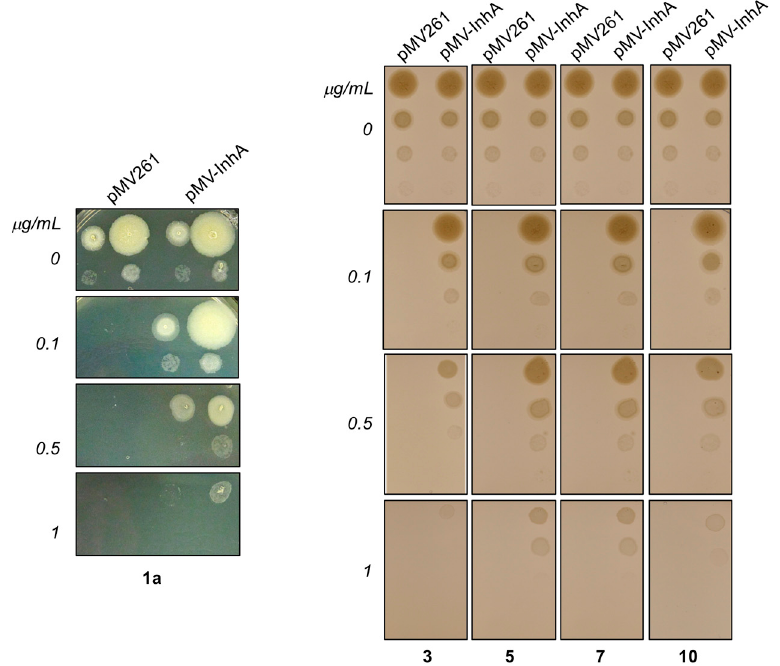
Figure 8. Determination of sensitivity of M.tb H37Ra pMV261 and M.tb H37Ra pMV261-InhA against 1a ( Left panel) and 3 , 5 , 7 and 10 ( Right panel) by drop dilution method.